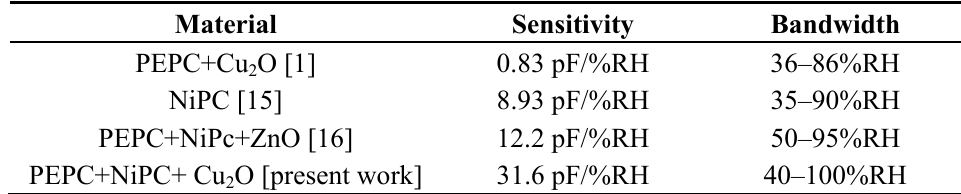
Table 1. Comparison of sensitivity and